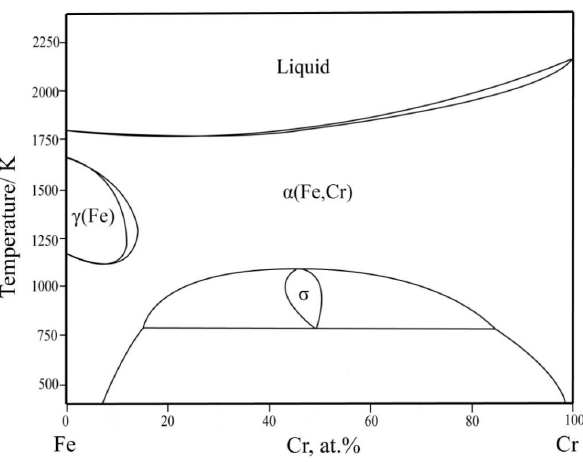
Figure 1. The calculated Fe–Cr phase diagram based on the work of Jacob et al. [31].